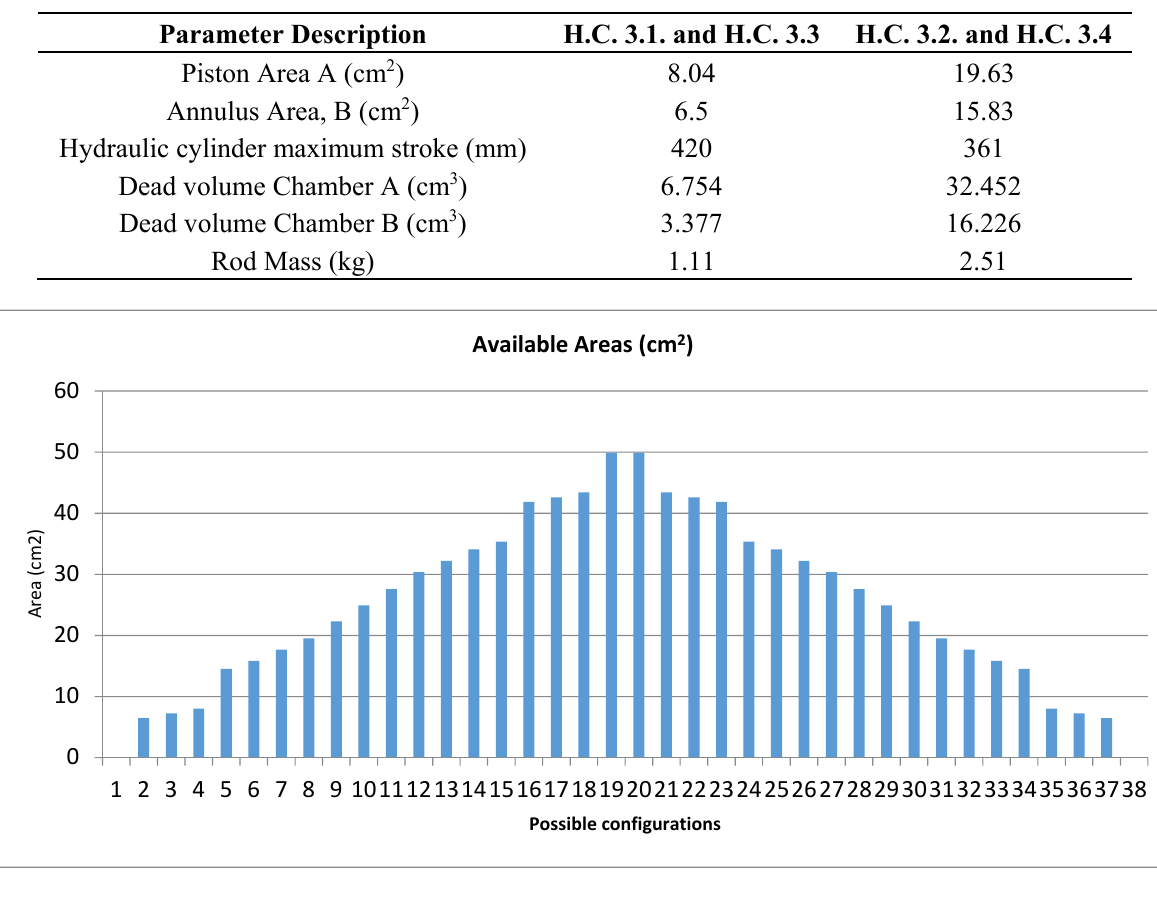
Figure 4. Hydraulic cylinder model including each associated elements. Table 2. Main parameters of the hydraulic cylinders.